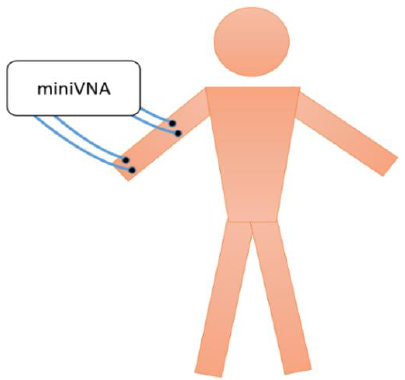
Figure 1. Experimental setup, where miniVNA (Vector Network Analyzer) is used to measure the channel gain/attenuation profile for different transmitter (TX)–receiver nodes (RX) separations and configurations.